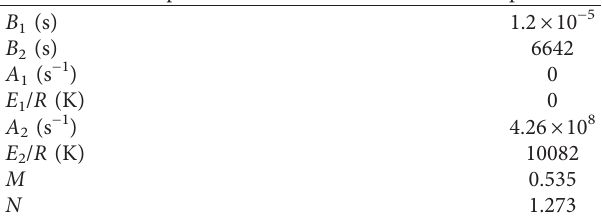
Table 2: Cure parameters defined for the NBR